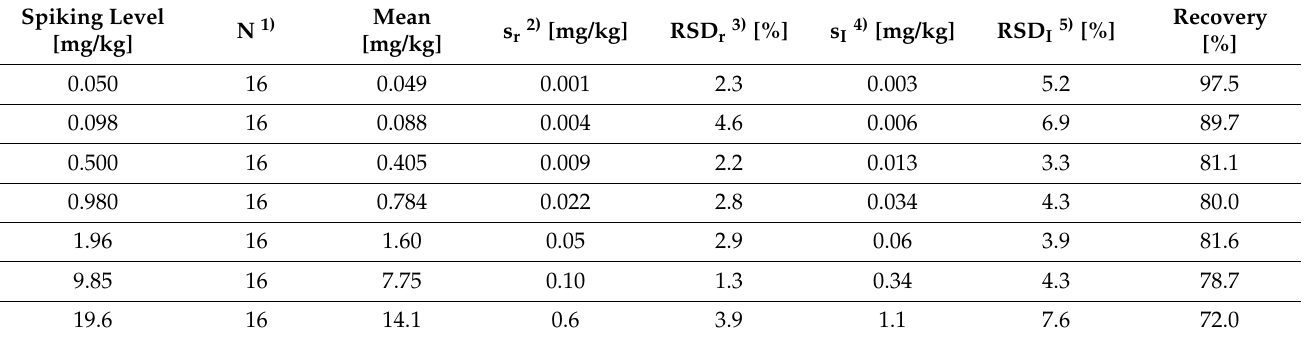
Table 3. Recoveries, repeatability, and intermediate precision obtained by DHS-VTT-GC-MS analysis of PDCB in beeswax using the internal standard PDCB-d4 for